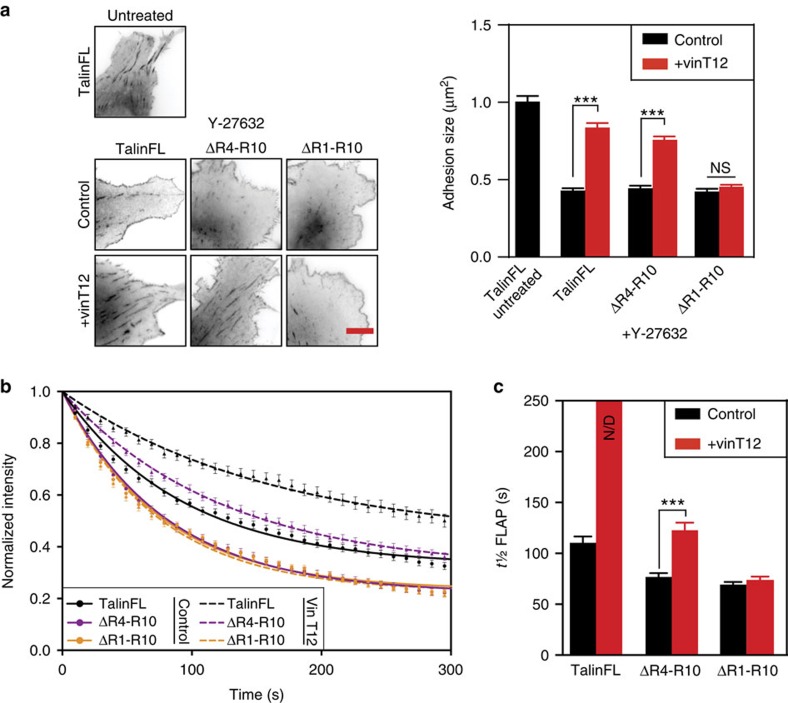
Vinculin regulates talin by binding to R1-R3 domains.(a) NIH3T3 cells expressing talinFL, talΔR1-R10 or talΔR4-R10 with vinFL (control) or vinT12 were treated with DMEM containing 50 μM Y-27632 or an equivalent volume of water for 30 min before fixation. The effect on adhesions was analysed assessing the signal from the expressed GFP-talin fusion constructs. FAs in control cells expressing talinFL are dramatically reduced in size following treatment with Y-27632. Note that talinFL and talΔR4-R10, but not talΔR1-R10, in FAs are stabilised by co-expression of vinT12 (n=15 cells, representative of three independent experiments, error bars are±s.e.m., ***=P<0.001 (ANOVA)); scale bar, 5 μm. (b) Curves from fluorescence loss after photoactivation (FLAP) experiments in NIH3T3 cells expressing either talinFL, talΔR4-R10 or talΔR1-R10 with and without vinT12. (c) Quantification of half-time of FLAP (t½ FLAP) to assess the mobility of talin constructs in FAs. Note that vinT12 reduces the mobility (increase of t½) of talinFL and talΔR4-R10 but not talΔR1-R10. The almost linear decay of talinFL in the presence of vinT12 prevented appropriate fitting, hence accurate t½ FLAP could not be determined; N/D, not determined (n=25–66 FAs, from three independent experiments, error bars are±s.e.m., ***=P<0.001 (ANOVA)).